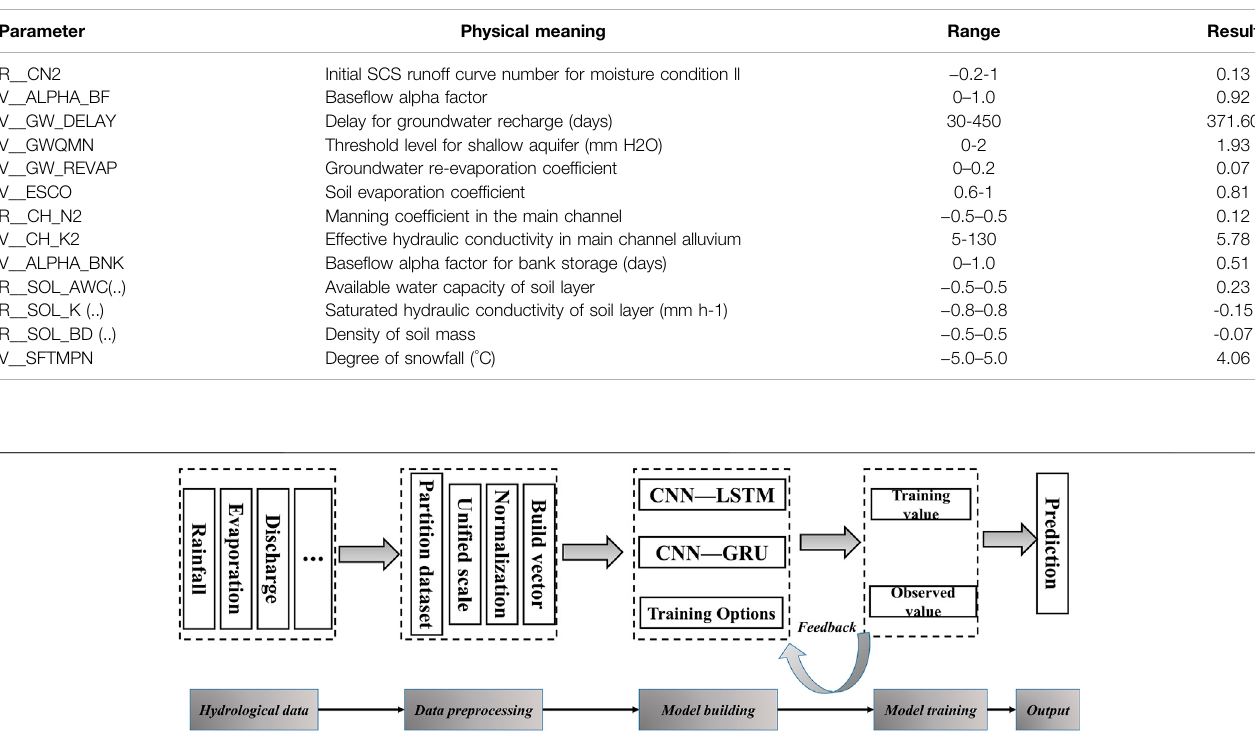
TABLE 2 | Calibrated values of the model parameters.